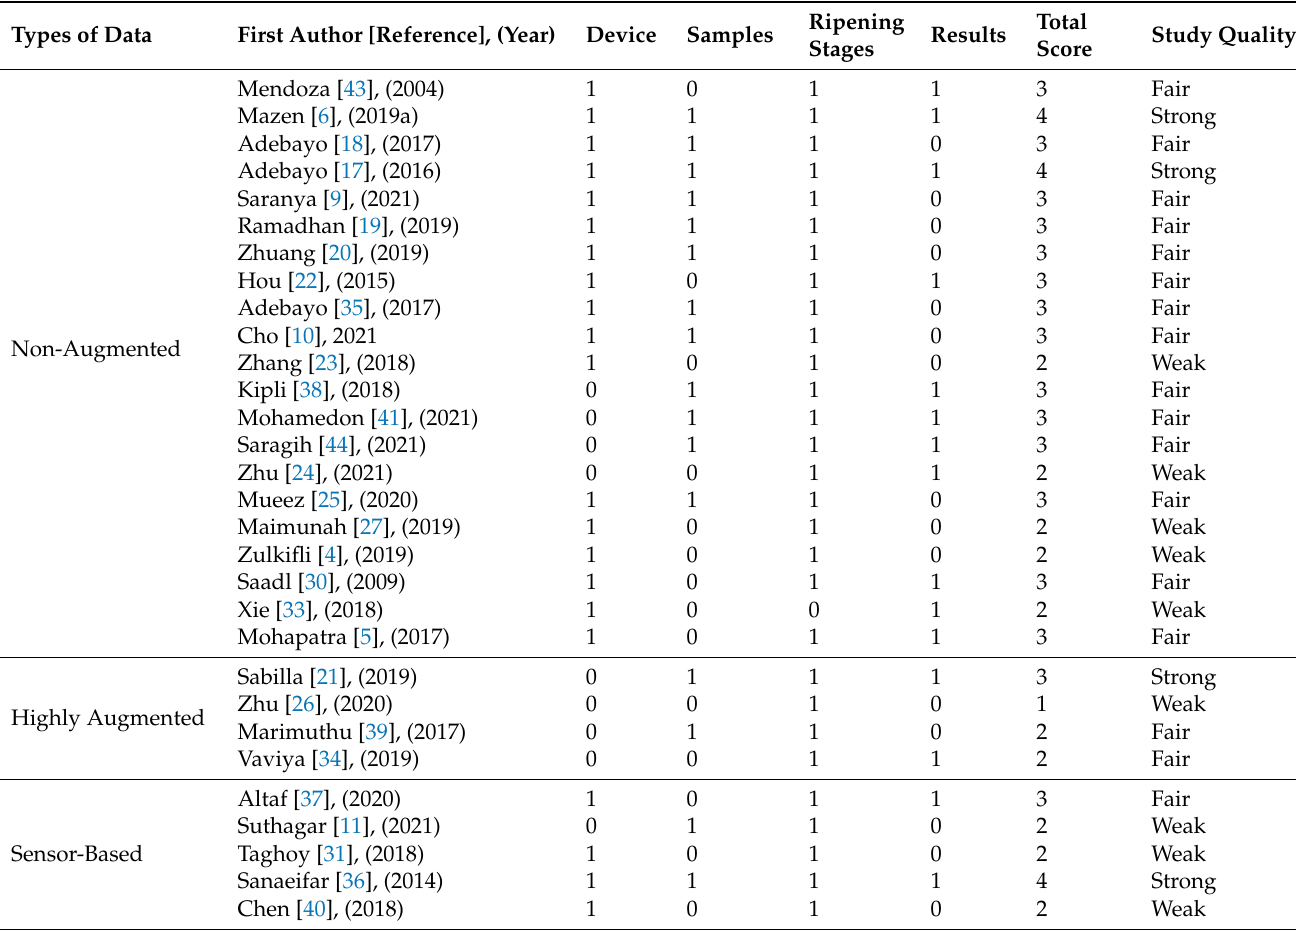
Table 4. Quality assessment studies analysis regarding the